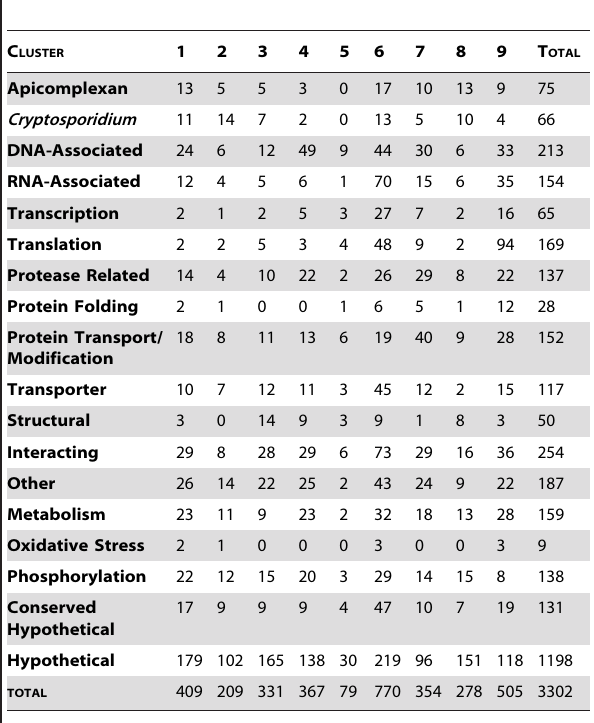
Table 2. Functional Categories Distribution across 2-72